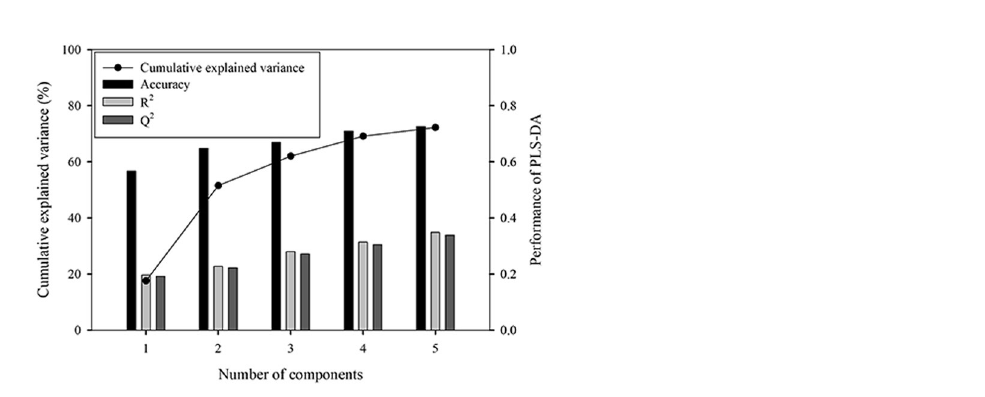
Figure 3. PLS-DA model performance and cumulative variance explained by different number of the top five